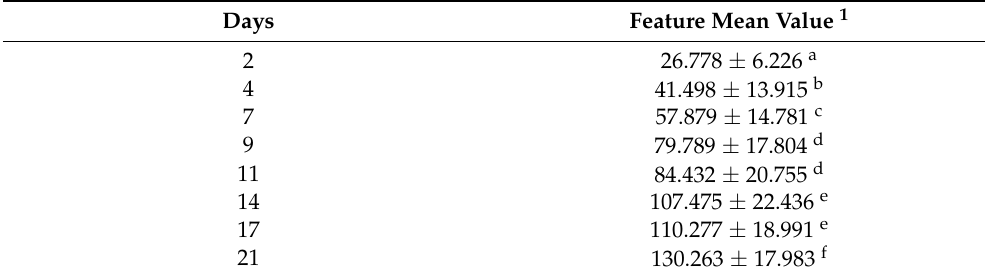
Figure 4. Colored images of the fruit ripening of the iodine-stained banana flesh during the 21-day storage period (i.e., days 2, 4, 7, 9, 11, 14, 17, 21). Table 1. Variations of the feature mean values of the intensities of all the grayscale image pixels of the iodine-stained banana flesh, on days 2, 4, 7, 9, 11, 14, 17, 21 of storage.